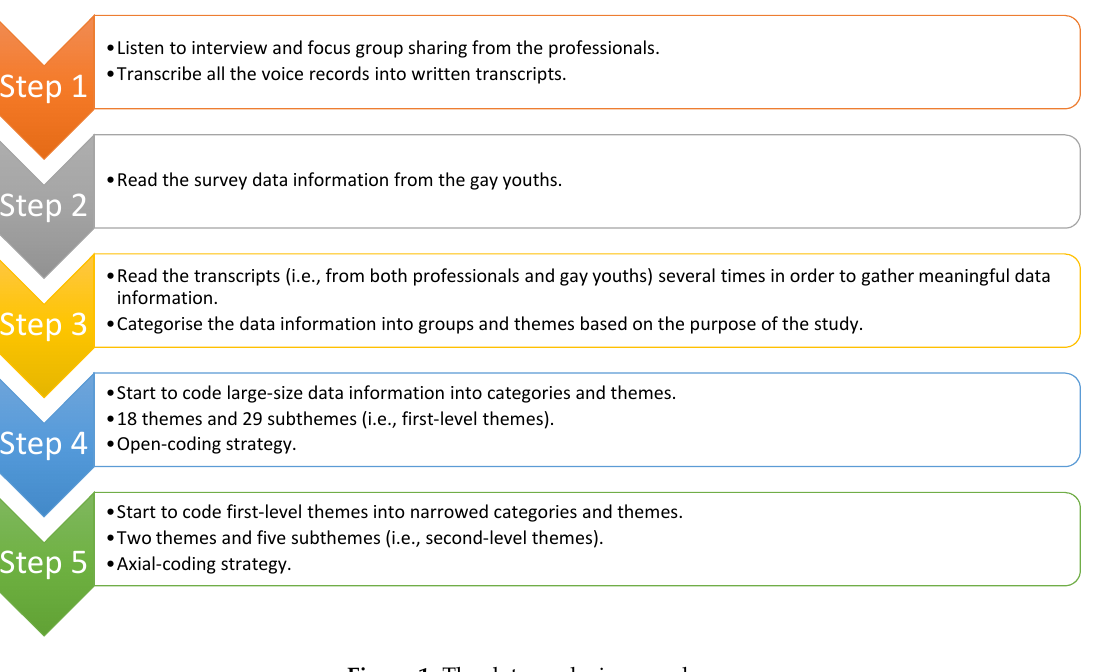
Figure 1. The data analysis